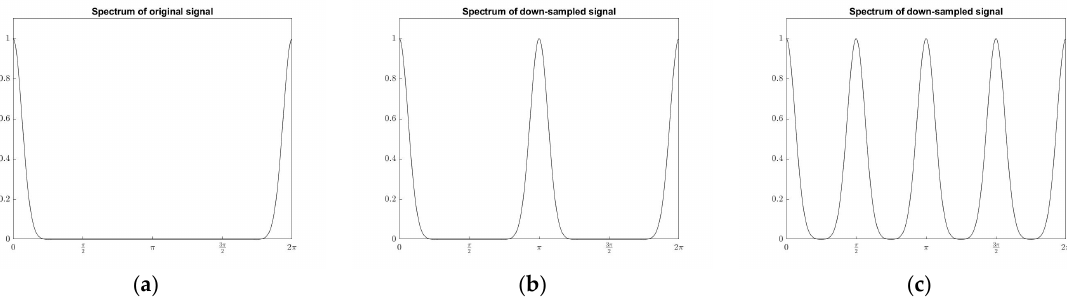
Figure 3. Frequency spectrum of signal I ( m ) : ( a ) without down-sampling, ( b ) after down-sampled by 2 times, ( c ) after down-sampled by 4 times.